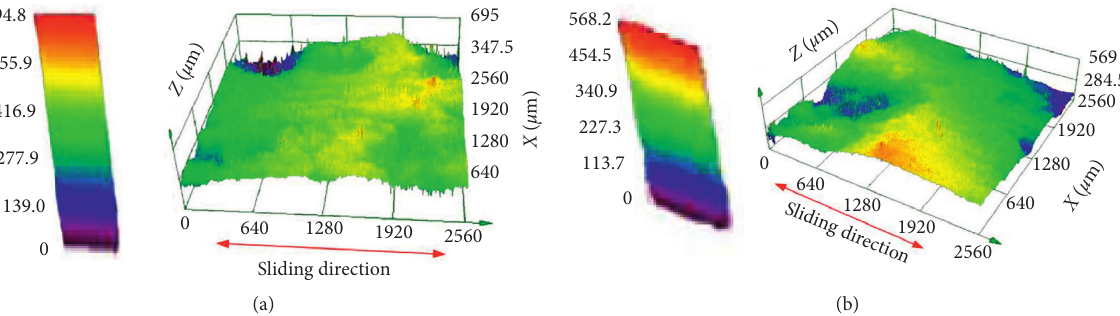
Figure 7: Surface morphology after the 1 st sliding. (a) Surface topography of position A after the 1st sliding. (b) Surface topography of position B after the 1 st